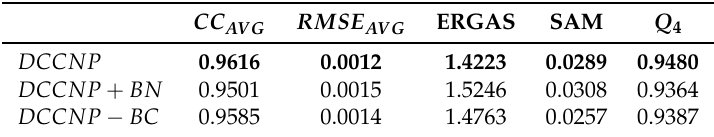
Table 5. Quantitative assessments of different experiment on the IKONOS data. BC, bottleneck layer and compression factor.